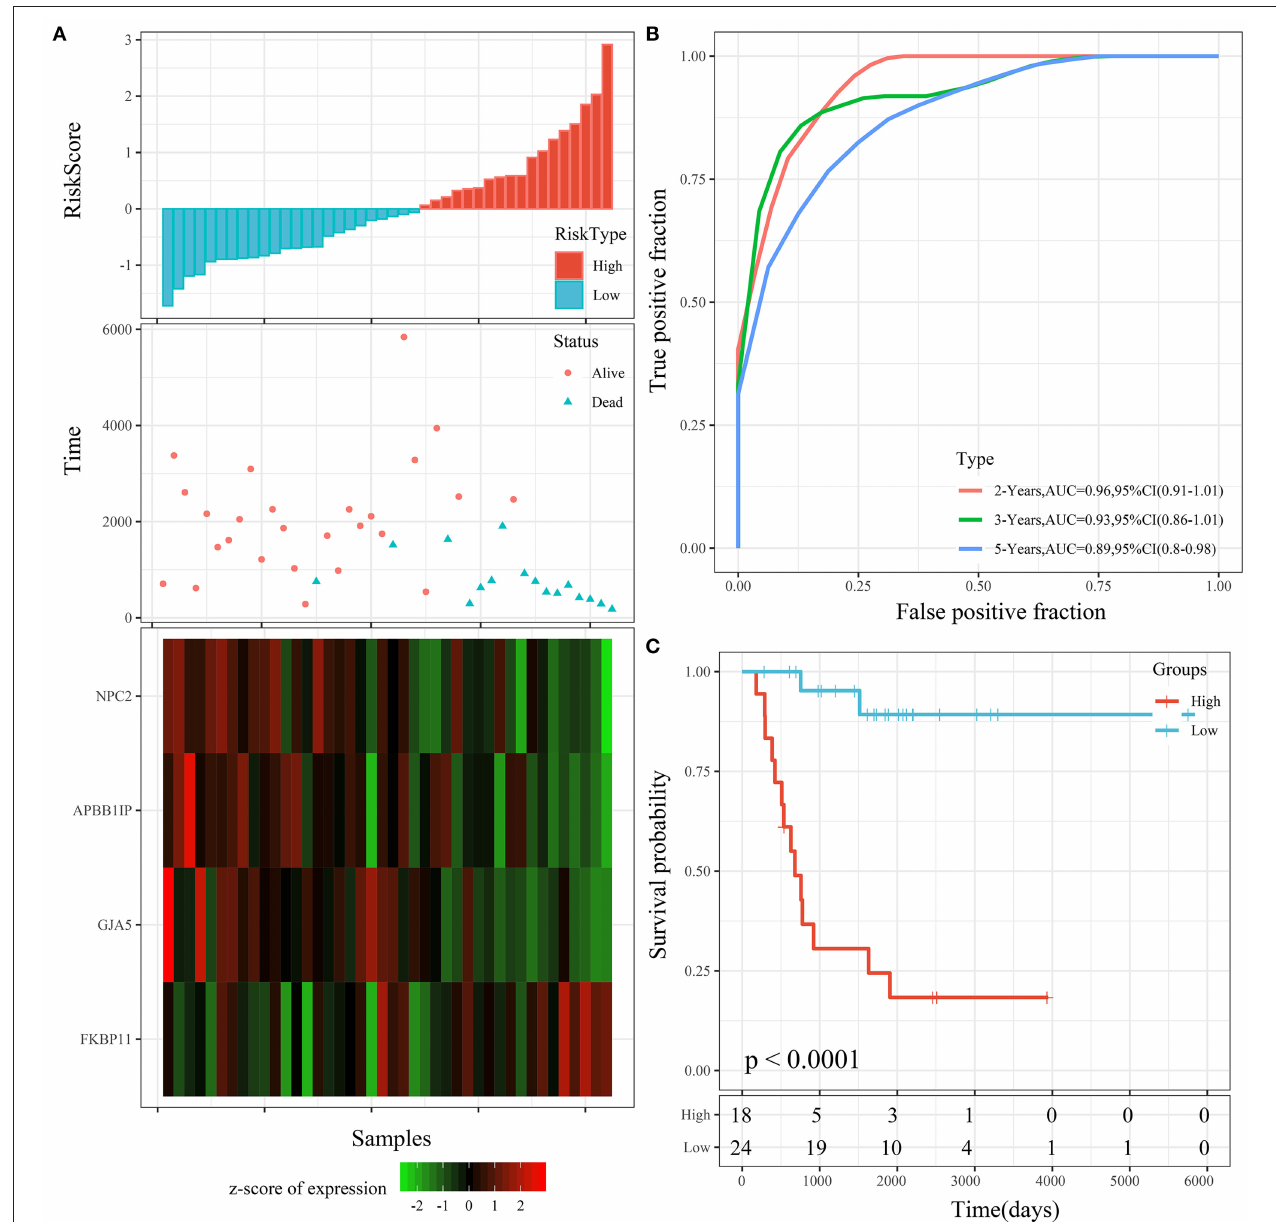
FIGURE 6 | (A) Risk score, survival time, survival status, and 4-gene expression in the TARGET training cohort. (B) ROC curve and AUC of the 4-gene signature. (C) KM survival curve distribution of the 4-gene signature in the TARGET training